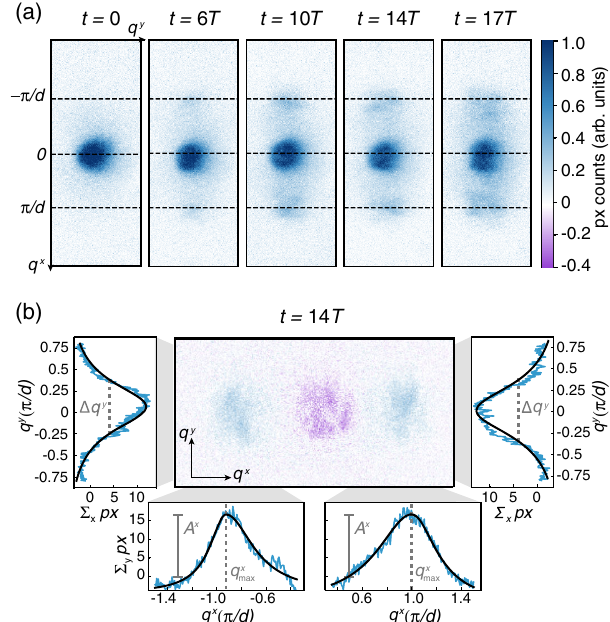
FIG. 2. Momentum-resolved images of the most unstable mode for α ¼ 1 . 78 , ω = ð 2 π Þ ¼ 720 Hz, and φ ¼ 0 . (a) Time series of absorption images after 6 ms TOF. The edges and the center of the first Brillouin zone (BZ) are marked by dashed lines. (b) Difference image at t ¼ 14 T , obtained by subtracting the condensate profile at t ¼ 0 . The lower panels show the 1D profiles along q x , resulting from summation of the difference image perpendicular to the lattice axis for the left and right excitation peak together with asymmetric Lorentzian fits (black solid lines), used to determine the amplitude A x and position q x (dashed lines) of the excitation peaks [52]. The left- and right- hand plots show the profiles resulting from summation along the lattice axis with Lorentzian fits to determine the transverse full width at half maximum Δ q y (dashed lines) of the peaks. Here, we integrate the density profile in a region of interest containing the left or right peak